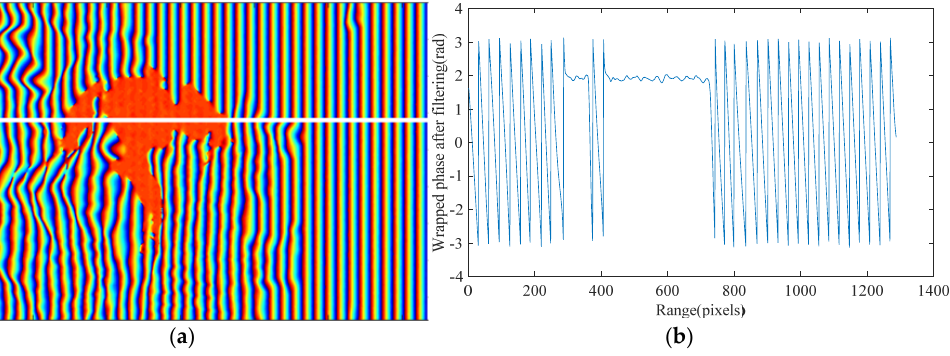
Figure 8. Filtered interferogram with false phase: ( a ) interferogram after filtering; and ( b ) cross ‐ section corresponding to the white line.